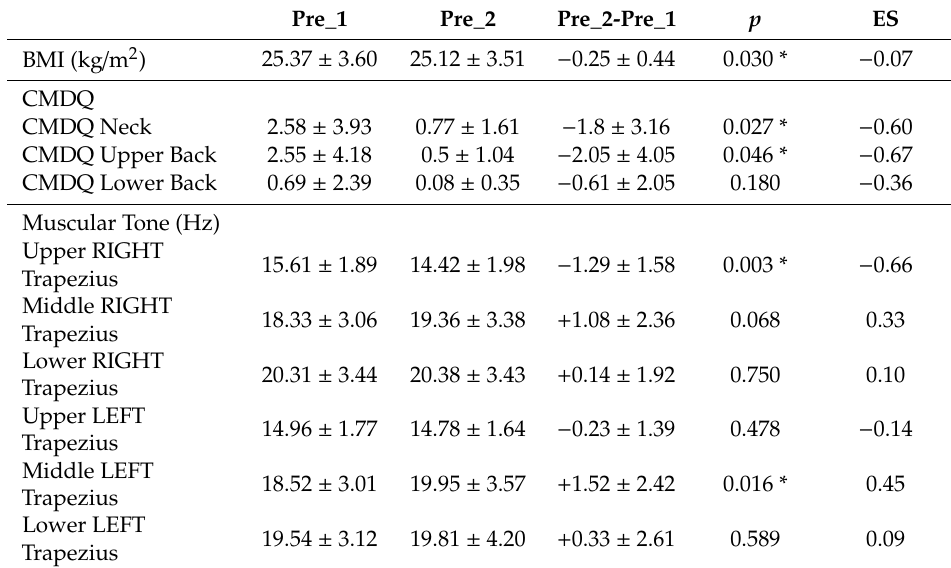
Table 3. Musculoskeletal discomfort and muscular tone in pre- and post-workday assessment after the intervention evaluation ( n = 19). Data are expressed as mean ±